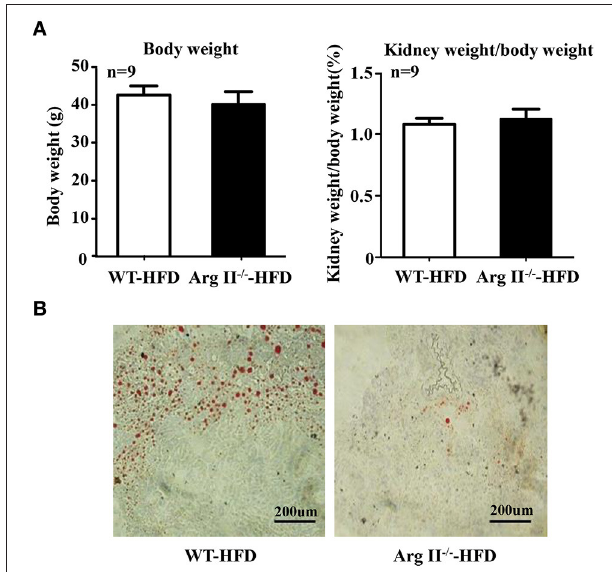
FIGURE 4 | Body weight, kidney weight/body weight ratio, and renal lipid accumulation in obesity. Starting at the age of 7 weeks, WT and Arg-II − / − mice were fed with HFD for 14 weeks. (A) Body weight and ratio of kidney weight/body weight after 14 weeks HFD; n = 11 for WT mice, n = 9 for Arg-II − / − mice. (B) Representative images of Oil Red O staining of renal section. n =